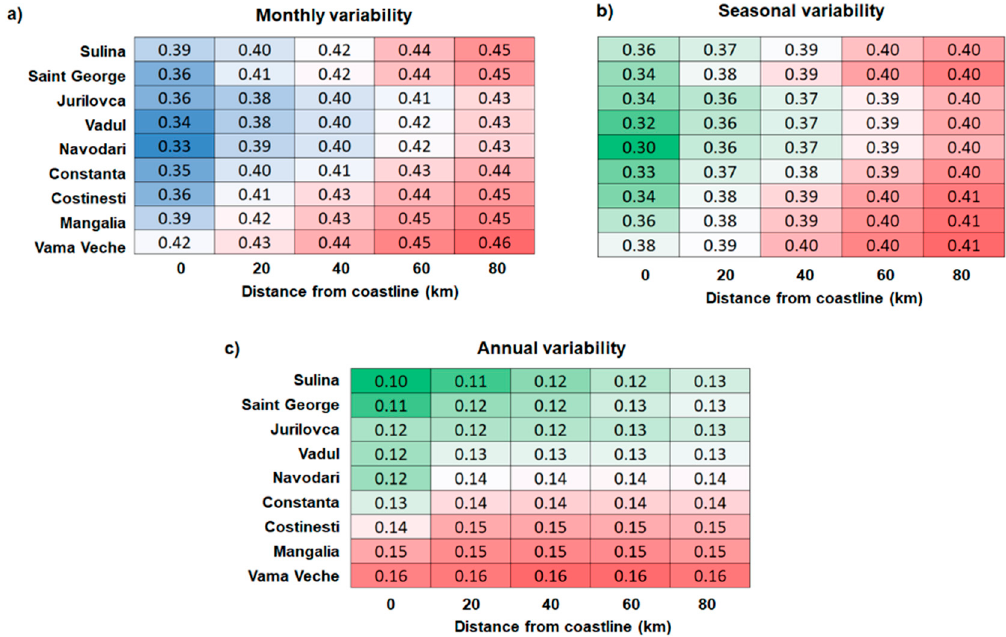
Figure 12. The variability of U 10 from the ERA-Interim database computed in each site: ( a ) Monthly variability; ( b ) seasonal variability; ( c ) annual variability.